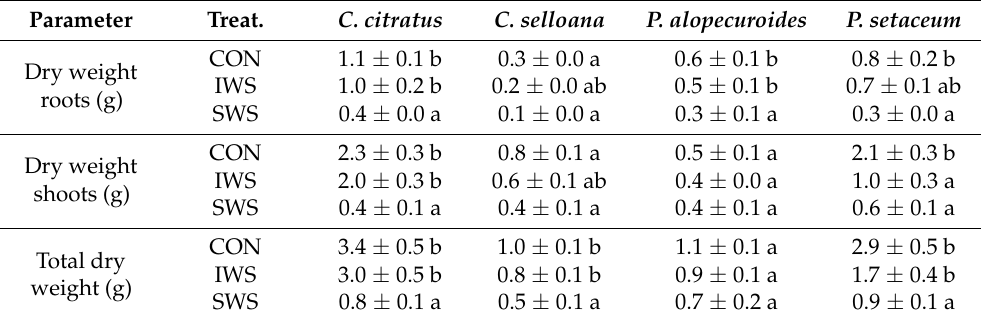
Table 3. Effect of stress treatments on the dry weight of roots and shoots ( n = 5). Different lowercase letters indicate significant differences between treatments with each species per parameter according to the Tukey test ( p < 0.05). Parameter Treat. C. citratus C. selloana P. alopecuroides P.